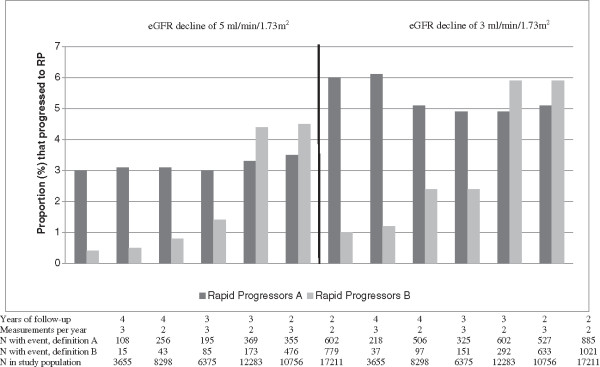
Proportion of patients that satisfy different RP definitions, for decline of 5 or 3 ml/min/1.73 m
2
.